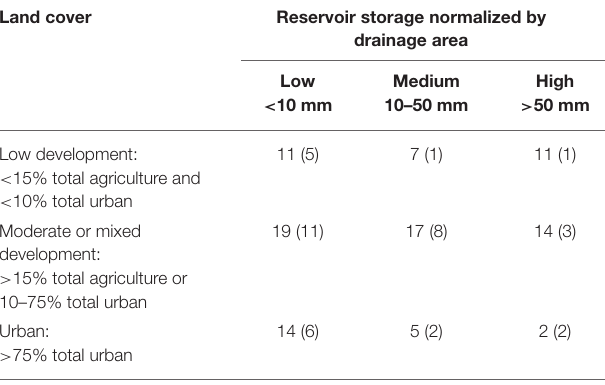
TABLE 1 | Number of streams stratified by reservoir storage and land cover. Land